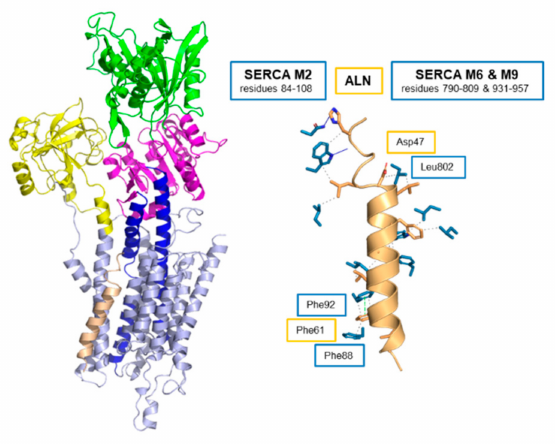
Figure 8. Molecular model of the SERCA-ALN complex. ALN is colored tan. SERCA is colored light blue with the actuator domain in yellow, the phosphorylation domain in magenta, the nucleotide- binding domain in green, and transmembrane segments M4 and M5 in blue. Also shown are the side-chain interactions between SERCA (blue) and ALN (tan). The relative locations of SERCA transmembrane segments M2, M6, and M9 are indicated. Interactions involving Asp 47 of ALN and Leu 802 of SERCA, and Phe 61 of ALN and Phe 88 and Phe 92 of SERCA are shown. For the full list of interactions, refer to Table